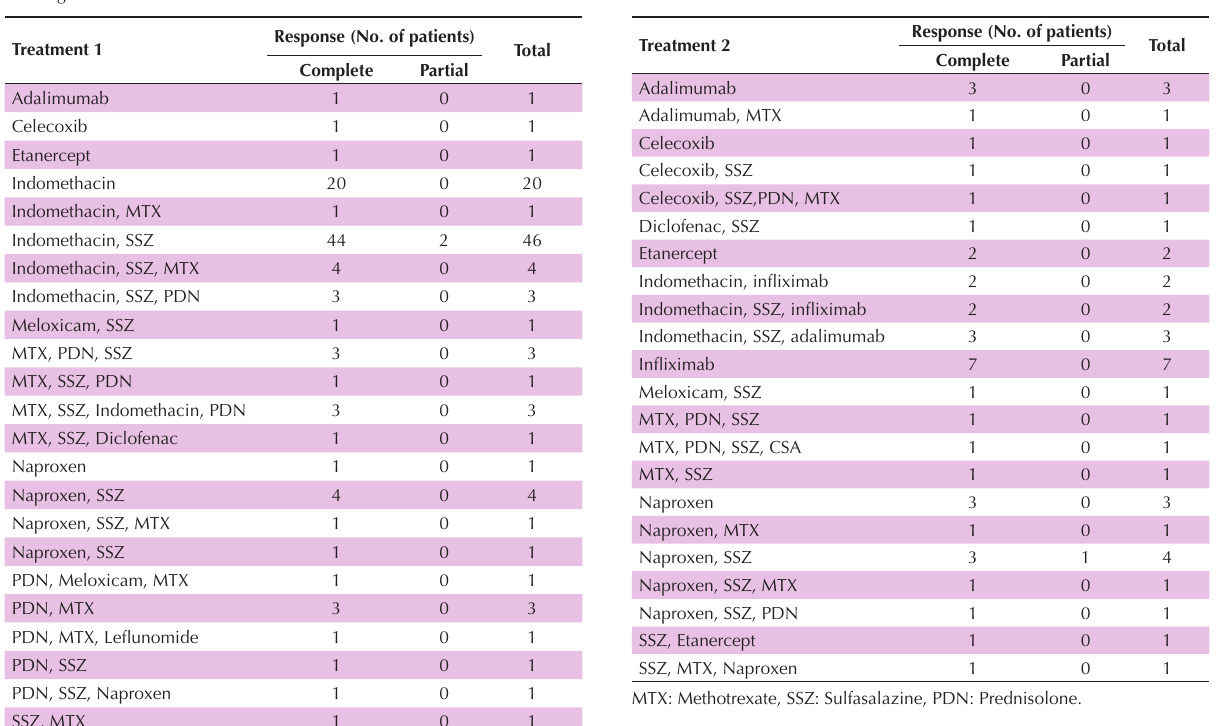
Table 9. Treatment response status (complete or partial) of drugs used in the first stage of treatment Response (No. of patients) Treatment 1